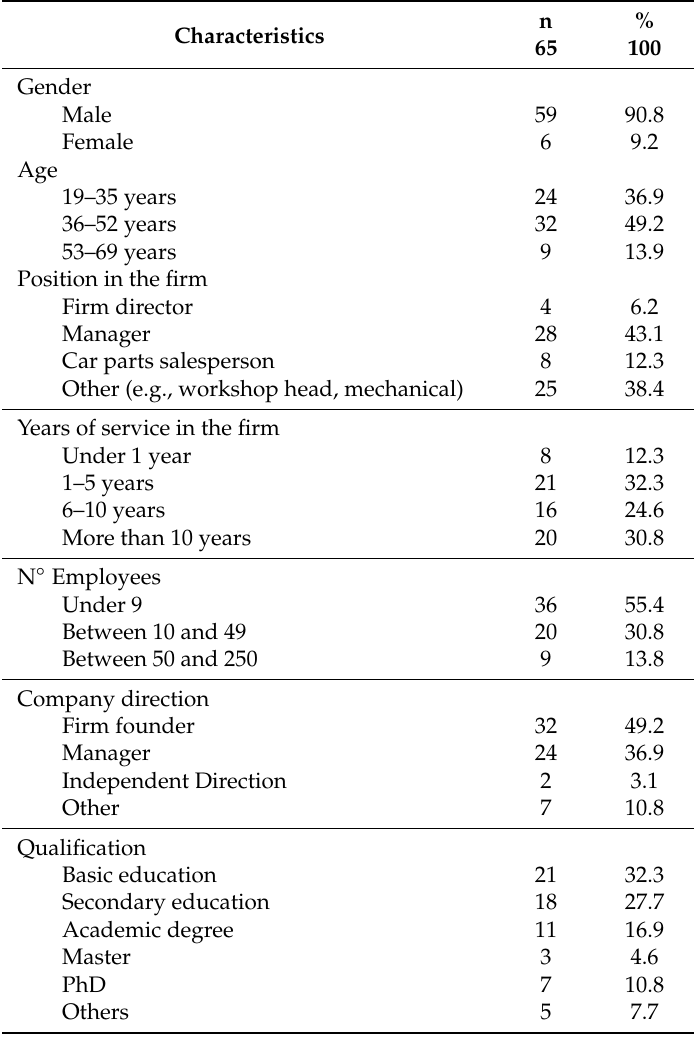
Table 1. Characterization of